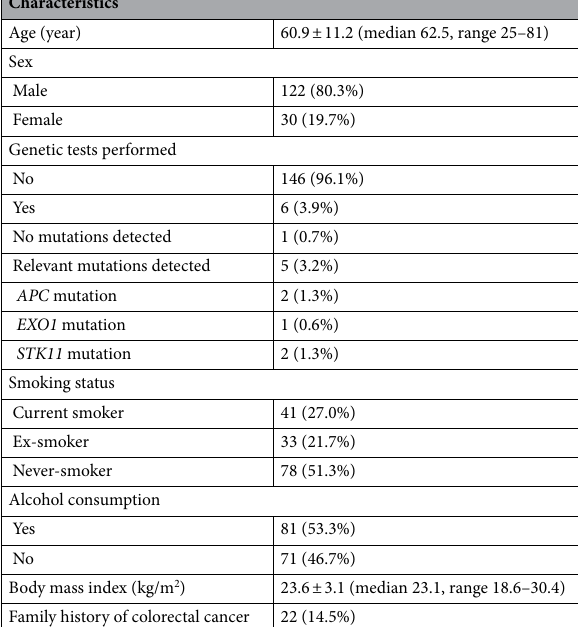
Table 1. Baseline characteristics of patients. Data are presented as n (%) or mean ± standard deviation with median and range. APC adenomatous polyposis coli, EXO1 exonuclease 1, STK11 serine/threonine kinase